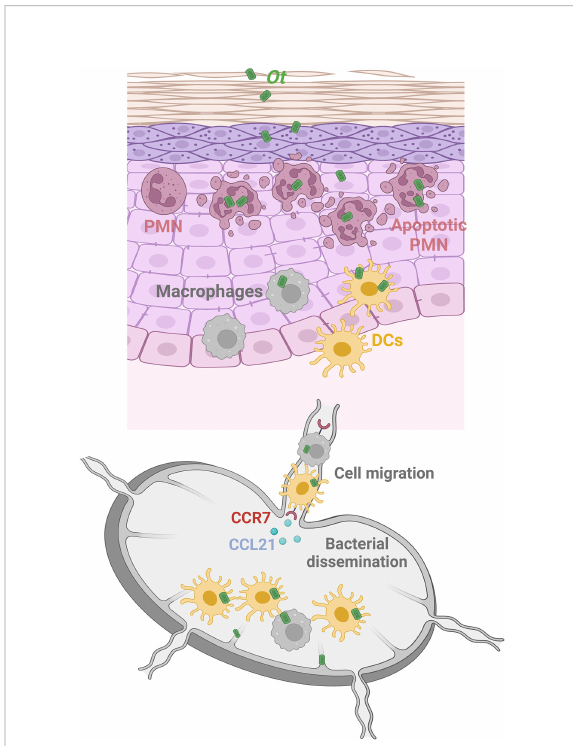
FIGURE 6 Graphical illustration of Ot dissemination and innate immune cell responses in an i.d. infection mouse model. Following i.d. infection with Ot , neutrophils are the fi rst responders and rapidly in fi ltrate the skin. Although neutrophils (purple) ef fi ciently engulf bacteria in the inoculation site, Ot induces neutrophil apoptosis locally, and neutrophils cannot carry Ot into the dLN. Instead, DCs (yellow) and macrophages (gray), which also migrate into the skin for bacterial uptake, are the reservoirs responsible for bacterial dissemination of Ot to the dLN. Notably, they may serve as “ Trojan horse ” vehicles that carry Ot and migrate into the dLN in a CCR7/CCL21- dependent way to facilitate bacterial replication and dissemination. In addition, lymphatic vessels are also infected by Ot , indicating that lymphatic ECs could be the target cells of Ot replication in the dLN for further bacterial dissemination into visceral organs. This graphical illustration is created with